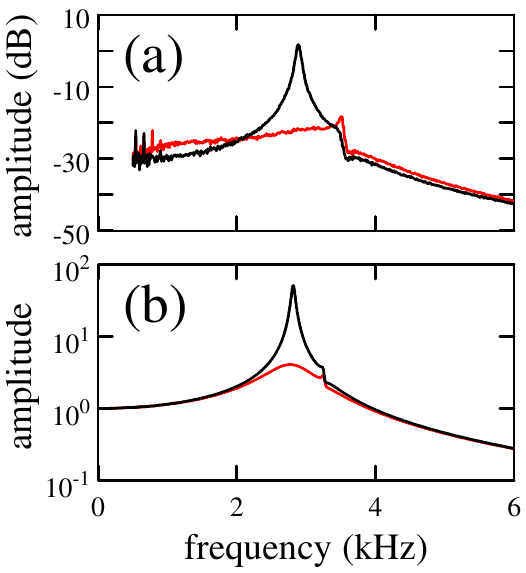
FIG. 5. (Color) Operation with passive harmonic-cavity voltage equaling 74% of that required for optimal bunch lengthening. Black curves: phase feedback off. Red curves: phase feedback on. (a) Experimental measurement of the transfer function amplitude. (b) Transfer function amplitude calculated with the beam energy spread equaling its natural